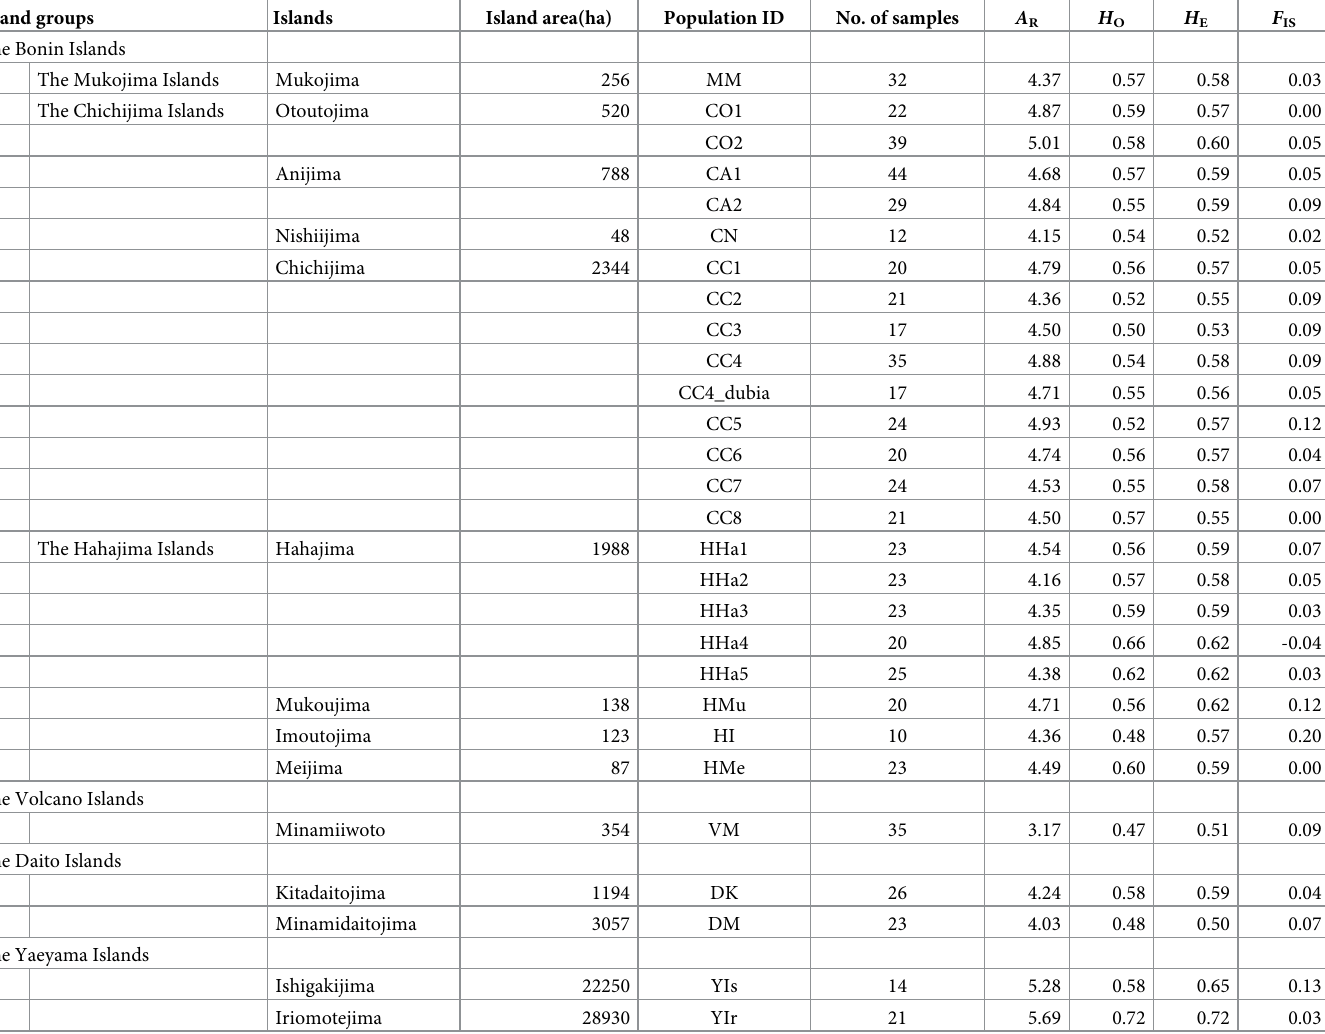
Table 1. Population genetic parameters estimated from 11 SSR for the 27 Planchonella obovata var. obovata and one P . obovata var. dubia population (CC4_dubia). Island